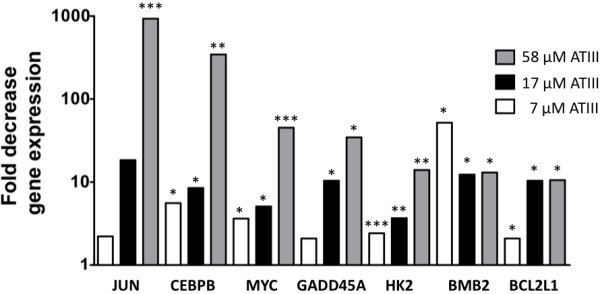
Key signal transduction pathfinder genes altered after ATIII treatment of HCV OR6 replicon. Analysis of activated signal transduction pathways in HCV OR6 replicon cells after treatment with ATIII. 5x104 HCV OR6 replicon cells were treated with 7, 17, 58 μM ATIII for 48 h. A real-time PCR expression array was used to analyze the expression of 84 key genes from 18 signal transduction pathways. Asterisks show genes with significant changes (*, P<0,05; **, P<0.01; *** P<0.001) in gene expression compared to vehicle control as calculated by the ΔΔCt method of three independent experiments are shown. All genes are normalized using the GAPDH house-keeping gene. Only genes with more than a 5-fold change in gene-expression are shown.